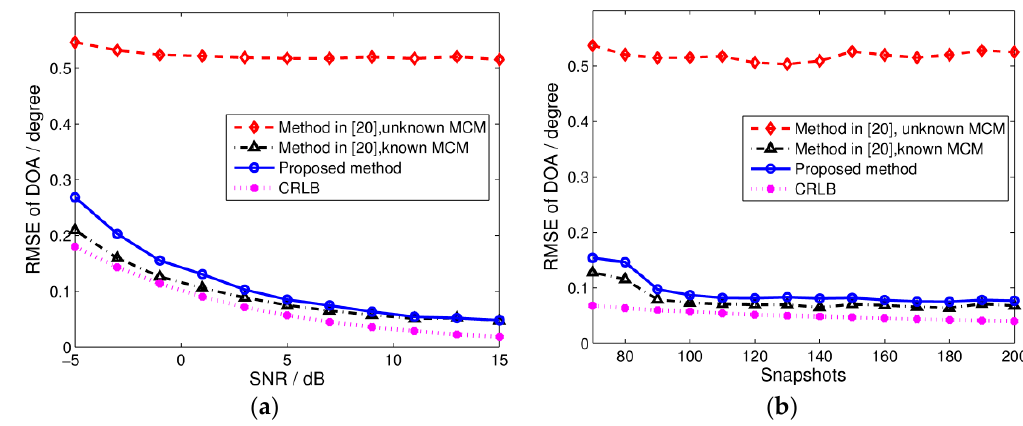
Figure 3. RMSE of wideband DOA estimation with 200 Monte Carlo trials. ( a ) RMSE versus input SNR, where snapshots = 100; and ( b ) RMSE versus the number of snapshots, where SNR = 5 dB.